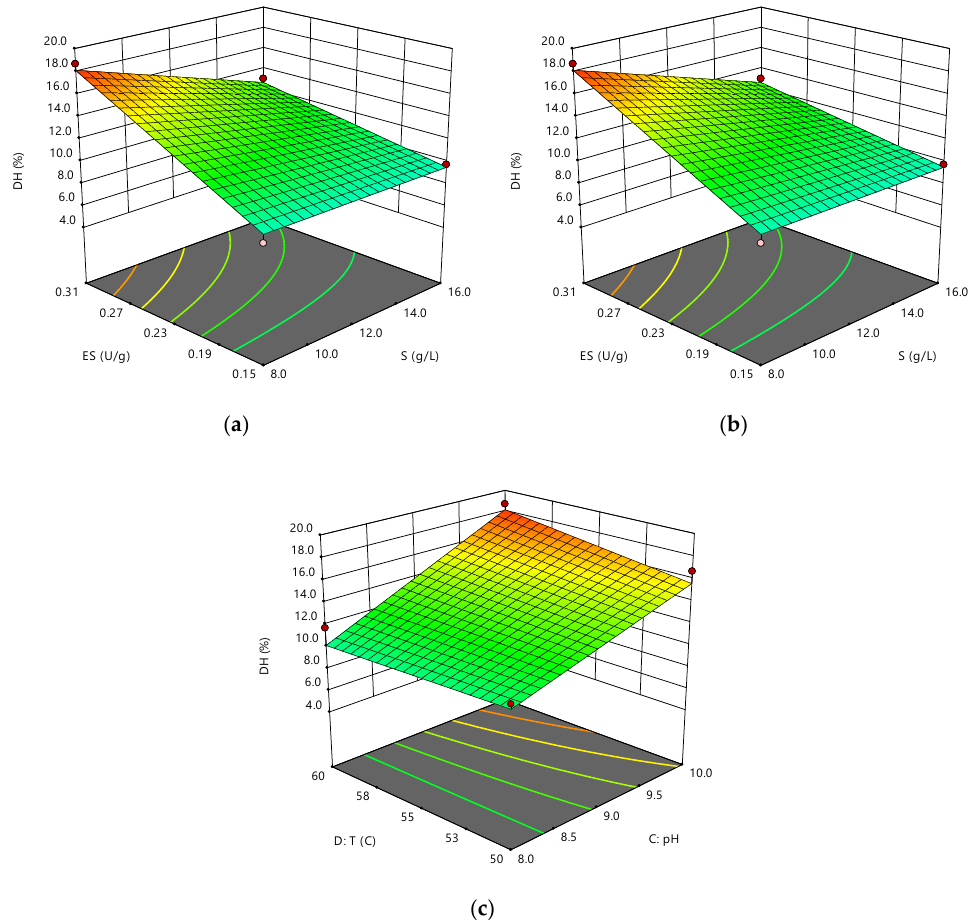
Figure 1. Response surface plots of the relative effects on the DH of ( a ) S and E / S; ( b ) E / S and pH; ( c ) pH and T.